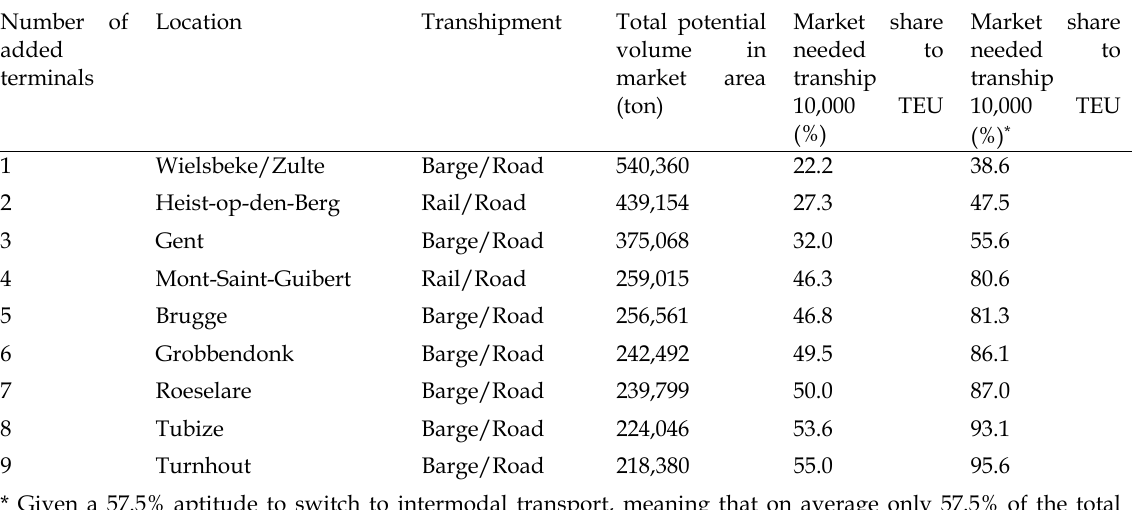
Table 1. Additional terminals and their estimated market potential (excl.